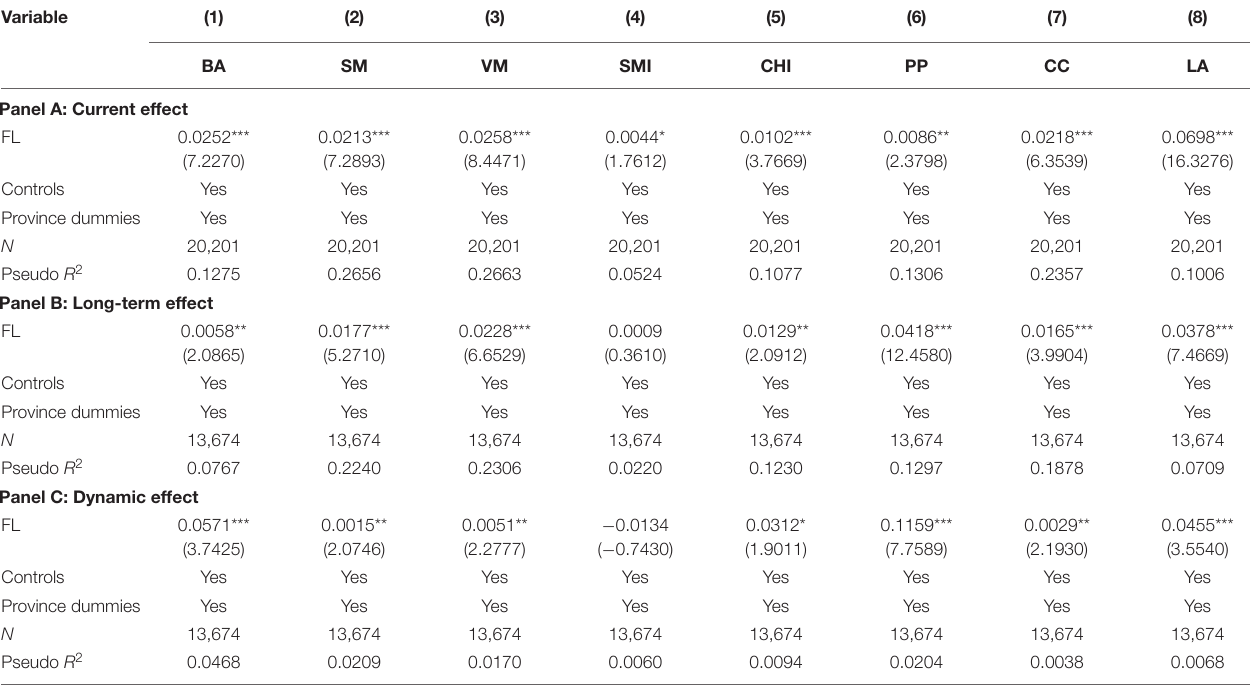
TABLE 10 | Robust test by excluding those individuals who worked in financial